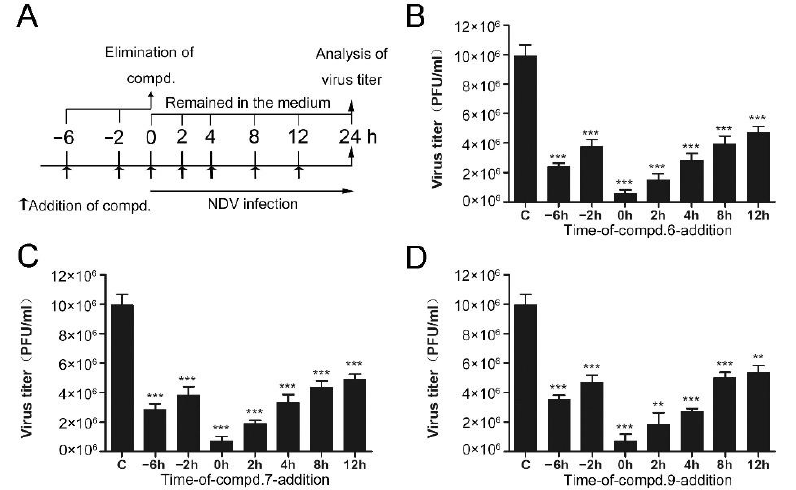
Figure 2. Time of drug-addition assay. ( A ) Compound treatment and NDV infection schemes in the “time of drug-addition” assay. ( B – D ) The virus yield in the supernatant was measured by plaque assay at 24 h post-infection. The data represent the mean ± SD of three independent experiments. The statistical significance was analyzed using a two-tailed Student’s t -test: ns (not significant); ** p < 0.01; *** p < 0.001.